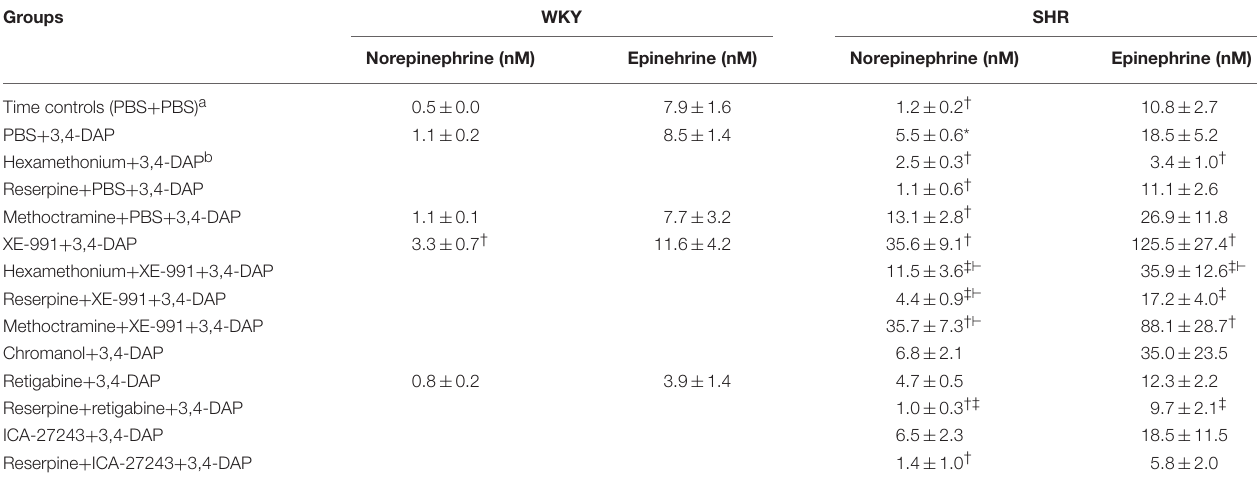
TABLE 2 | The concentration of catecholamines in plasma after